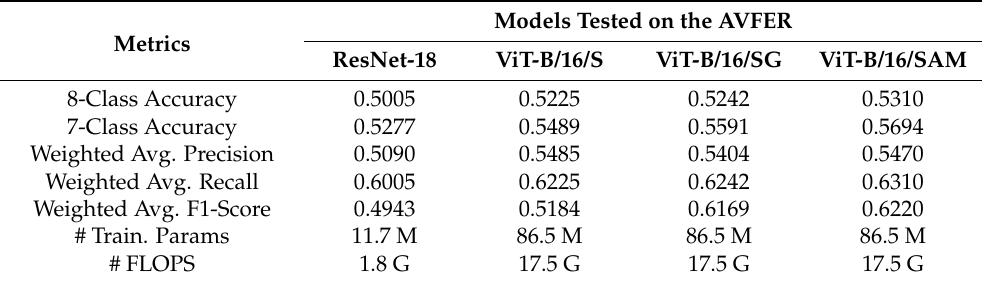
Figure 9. Cross-entropy loss landscape on ViT with SAM’s application during the training on AVFER. Table 1. Testing accuracy (with approximation to 8 and 7 classes), weighted average precision, recall, and F1-score on project models tested on